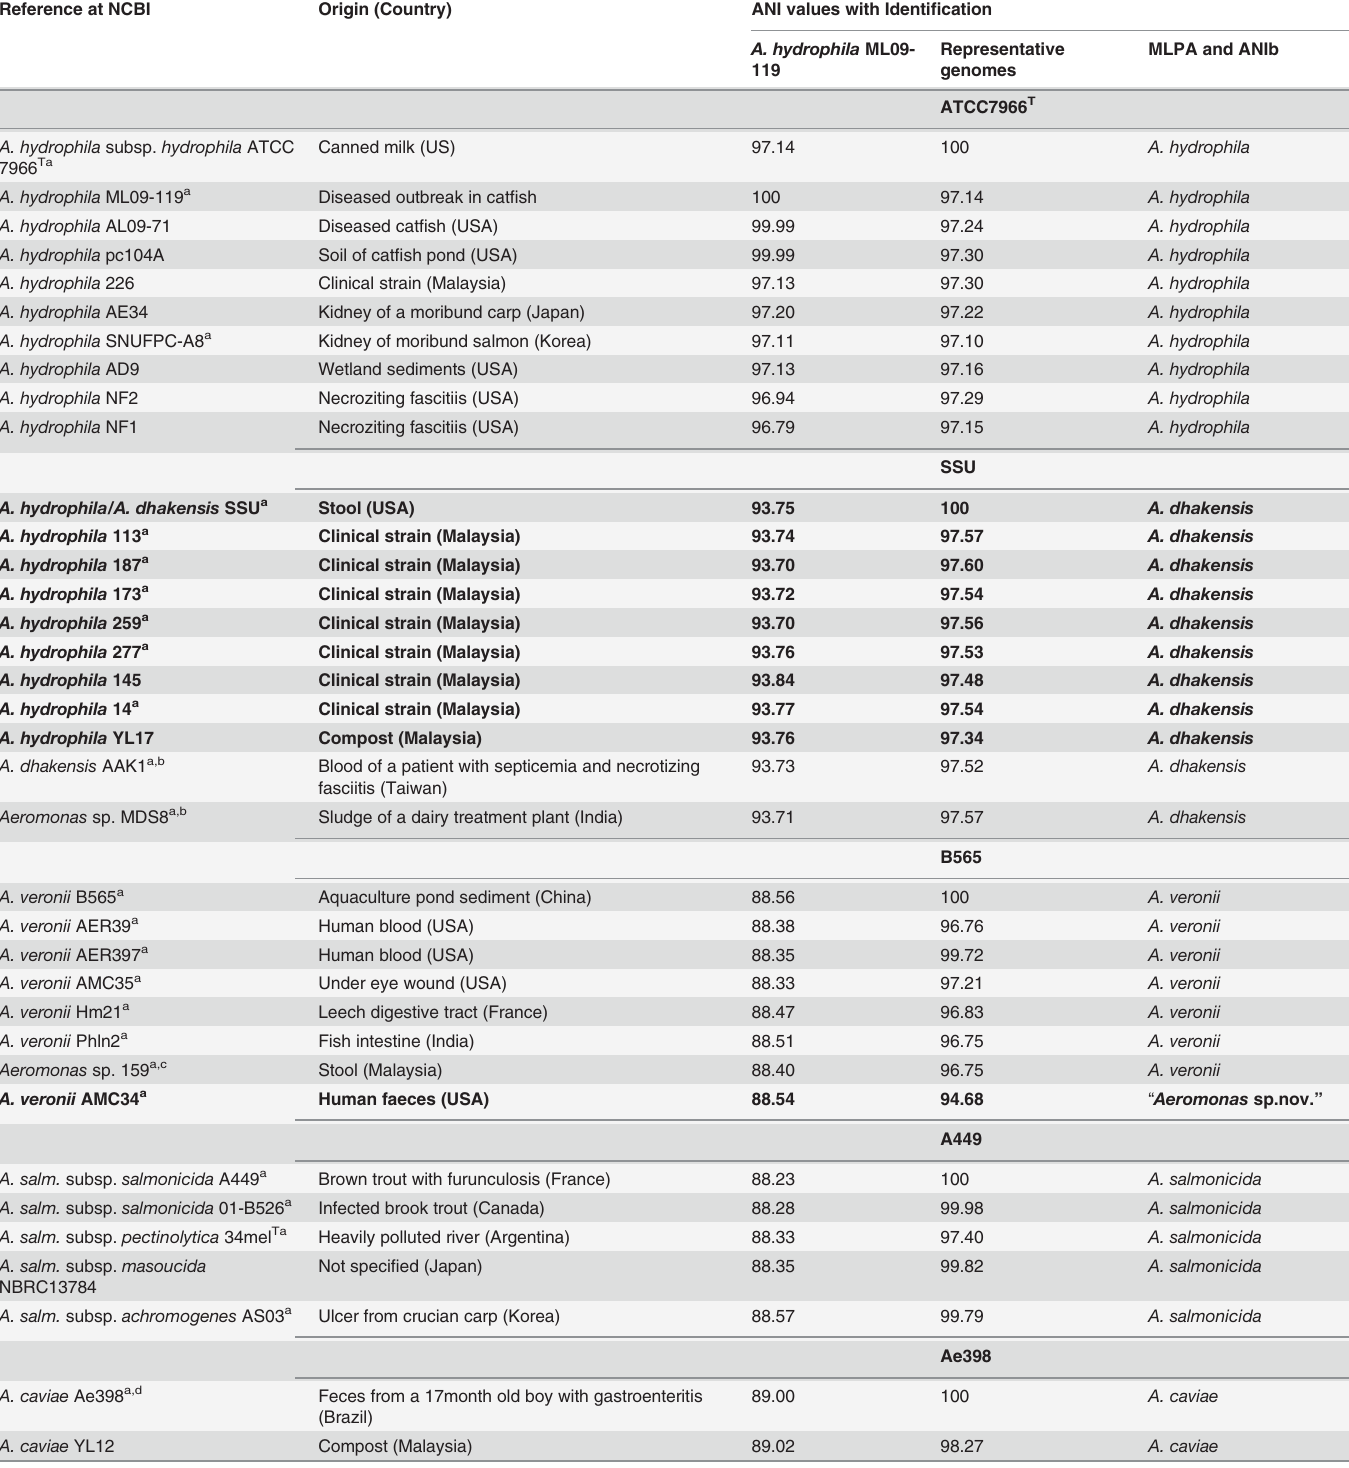
Table 1. Intra and inter-species ANI values for the 44 Aeromonas genomes and identi fi cation on the basis of the MLPA and ANI (mislabeled genomes in bold). Reference at